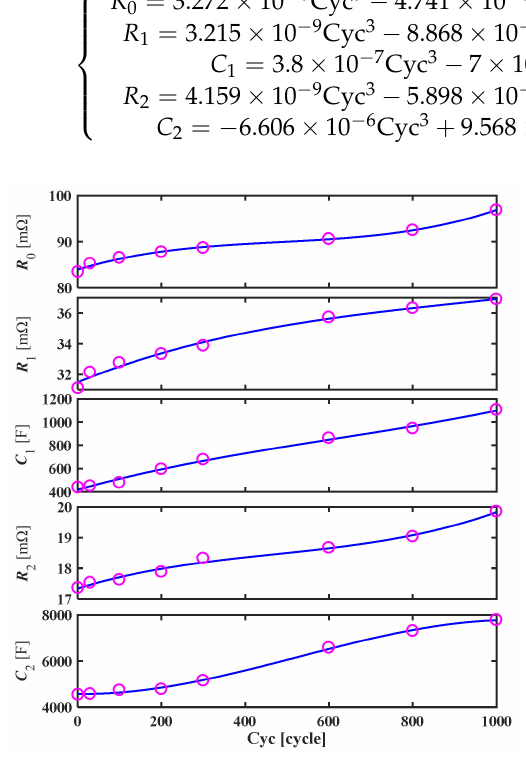
Figure 5. The variations of parameters vs. Cyc by curve fitting method. Table 4. The identified parameters of LIB